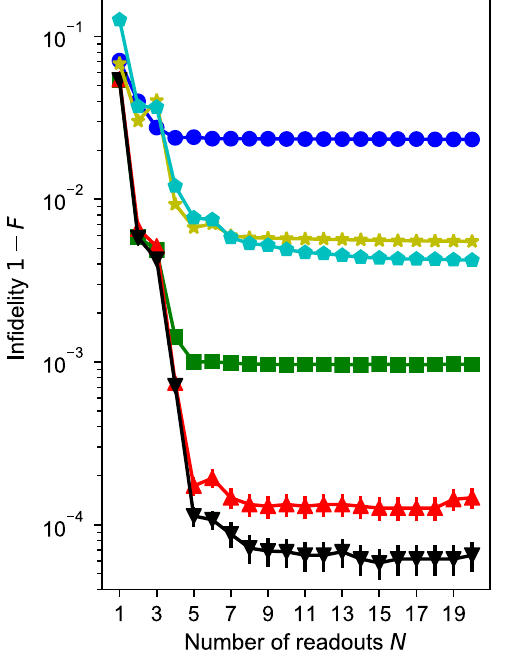
FIG. 6. High-fidelity measurement of bosonic codes. Results of measuring the logical Z observable in different qubit encodings. Given single-shot ancilla assignments, a Bayesian ” or “ 1 classifier outputs either “ 0 , ” according to its best L L estimate of the initial state. As more readouts are incorporated into the estimate, the measurement infidelity decreases mono- tonically. Results for the 0 – 2, 0 – 3, 0 – 4, and 0 – 5 Fock codes are shown in blue circles, green squares, red triangles, and black triangles, respectively. Results for the first- and second-order binomial codes are shown in yellow stars and cyan pentagons, respectively. As the code distance increases, the measurement fidelity